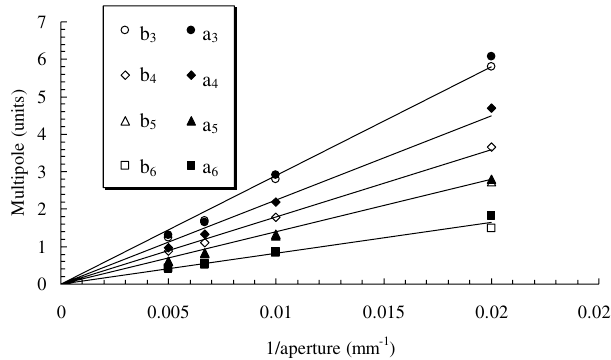
FIG. 9. Multipole rms obtained with 0.015 random movement versus inverse of the